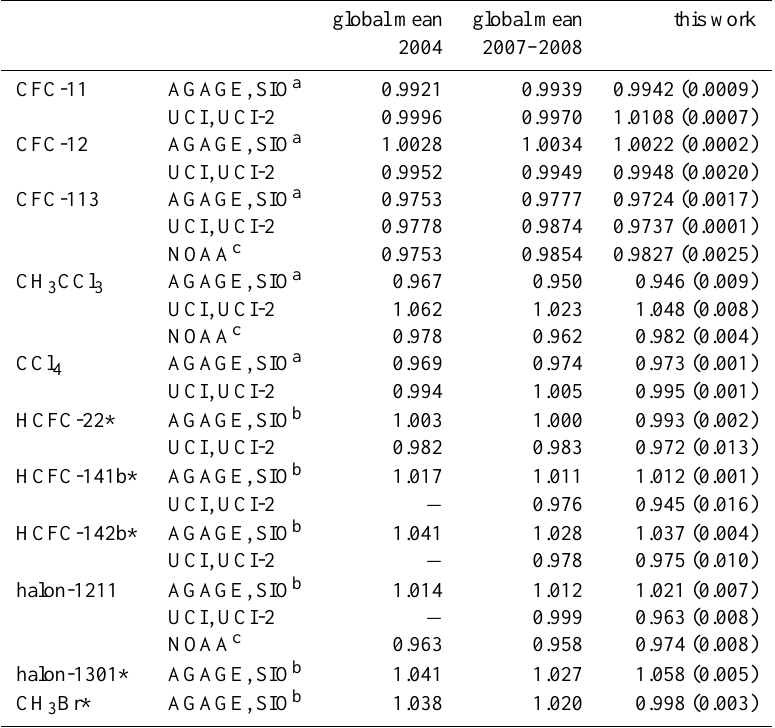
Table 6. Scale factors (relative to NOAA) derived from tropospheric global mean mole fractions reported in Table 1.1 of Montzka et al. (2011) for 2004 and 2007–2008, and from undiluted IHALACE samples (mean and standard deviation) for representative laboratories. Factors derived from AGAGE and UCI (University of California Irvine) global mean estimates can be compared with IHALACE factors from SIO and UCI-2, respectively. Unless otherwise specified, ratios were derived relative to NOAA ECD